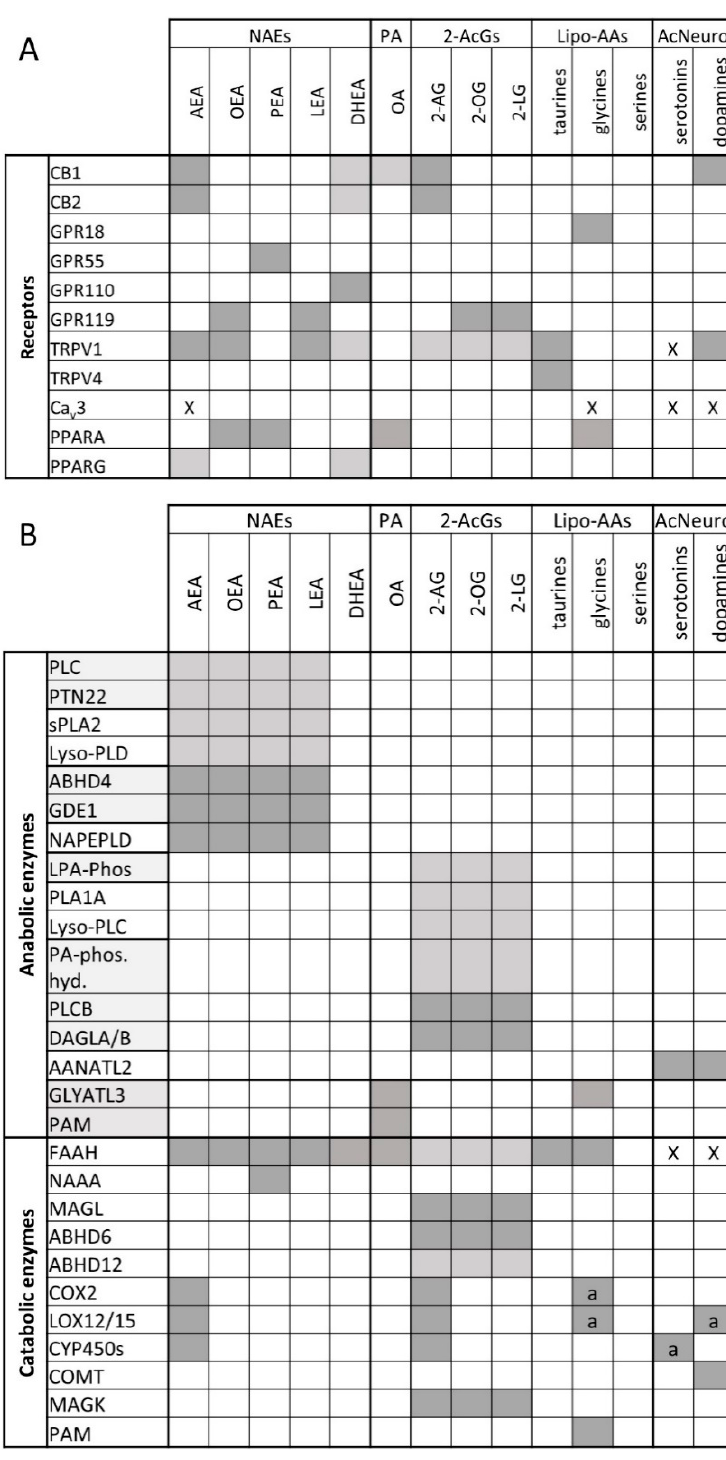
Figure 1. Endocannabinoidome mediators and their receptors ( A ) and anabolic and catabolic enzymes ( B ). Interactions are indicated by dark shaded boxes, and anabolic enzymes that function in concert are grouped together; “X” indicates inhibitory interactions; “a” indicates that enzymes only function with arachidonoyl homologs. A lighter shade of gray indicates a lower interaction with the receptors or a lesser role of the enzymes in biosynthesis or degradation.